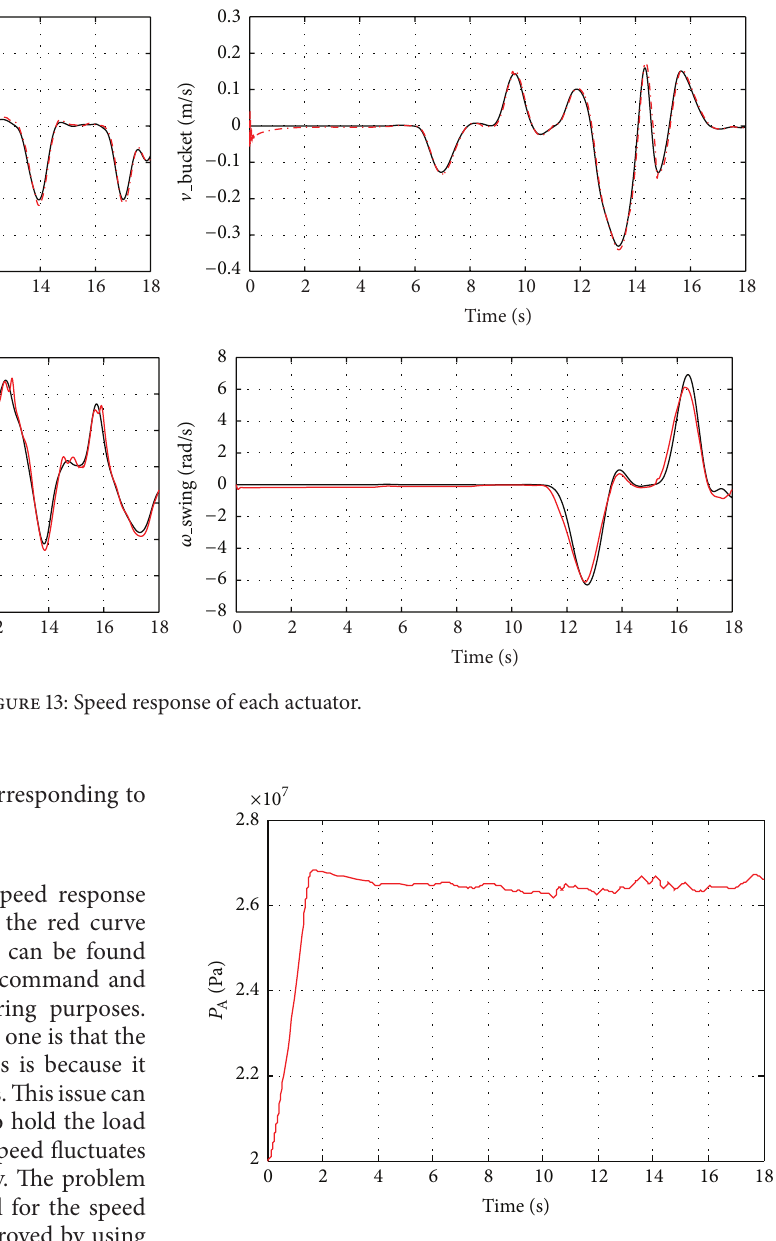
Figure 14: Pressure change of